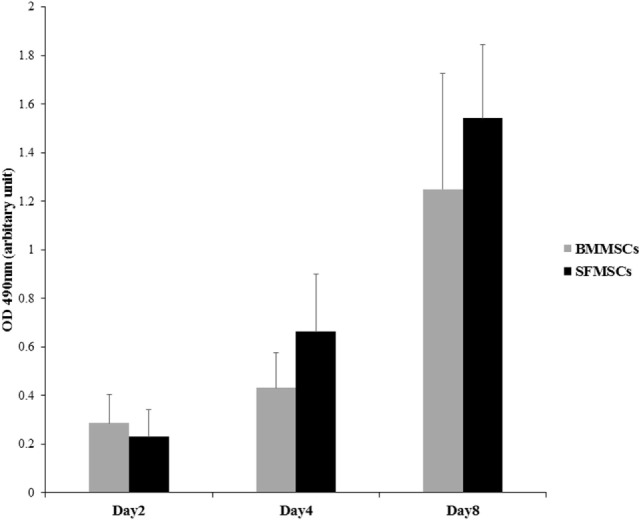
Measurement of cell proliferation of bone marrow-derived mesenchymal stem cells (BMMSCs) and synovial fluid-derived mesenchymal stem cells (SFMSCs). MTS assay was used to evaluate the rate of proliferation over a period of 8 days. Absorbance, optical density at 490 nm is linearly related to the cell numbers and hence represents the proliferation at a given time point. Increase in the optical density between two time points can be used as an index to measure the rate of proliferation. Data are presented as means ± SD. Error bars represent the SD.